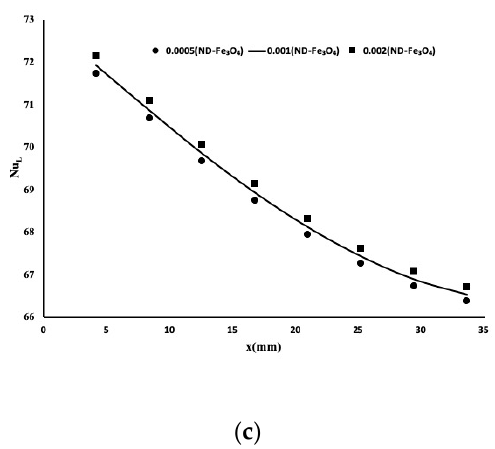
Figure 6. Heat enhancement using ND–Fe 3 O 4 in water mixture. ( a ) Temperature variation along the flow, ( b ) Nusselt number of each individual mixture, ( c ) Nusselt number using standard definition.